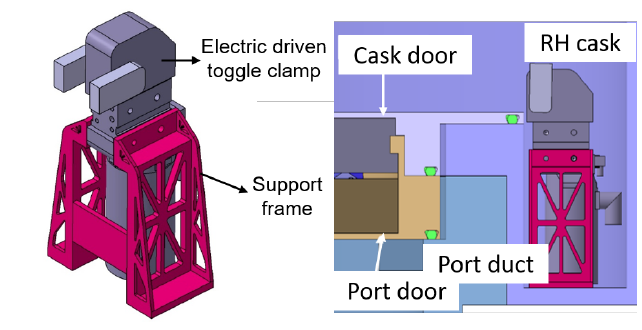
Figure 6. The locking mechanism between the cask door and